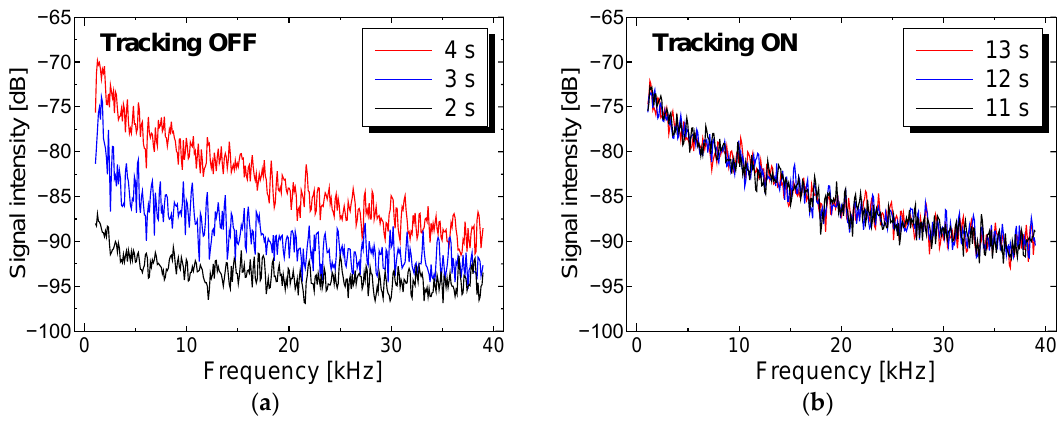
Figure 8. Stabilization of perfusion spectra with motion tracking. Flow velocity was constant at 27 mm/s. ( a ) Perfusion spectra with tracking OFF for 2, 3 and 4 s; ( b ) with tracking ON for 11, 12, and 13 s.